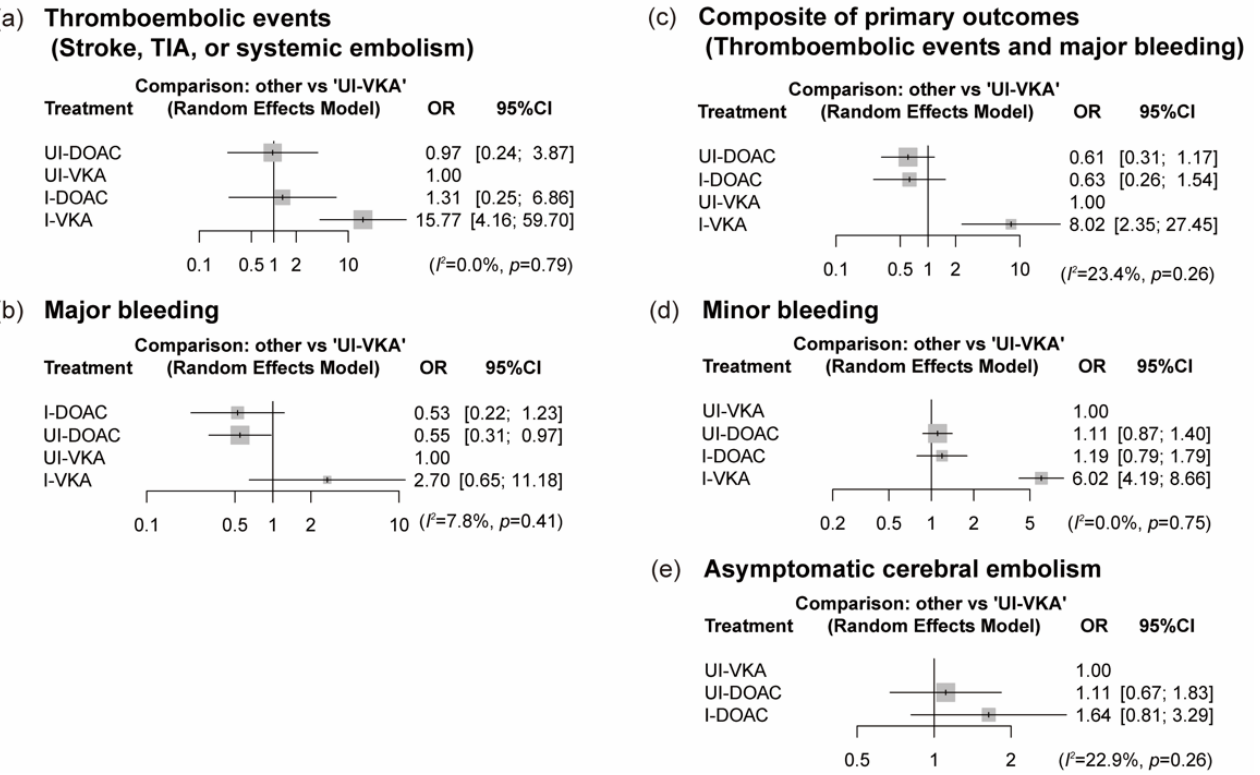
Figure 3. Forest plots for efficacy and safety of anticoagulant strategies compared with UI ‐ VKA. ( a ) The efficacy of thromboembolic events (stroke, TIA, or systemic embolism); ( b ) the safety of major bleeding; ( c ) the efficacy and safety of the composite of the primary outcomes (stroke, TIA, or systemic embolism and major bleeding); ( d ) the safety of minor bleeding; and ( e ) the efficacy of asymptomatic cerebral embolism. TIA, transient ischemic attack; OR, odds ratio; CI, confidence interval; UI, uninterrupted; I, interrupted; DOAC, direct oral anticoagulant; VKA, vitamin ‐ K antagonist.